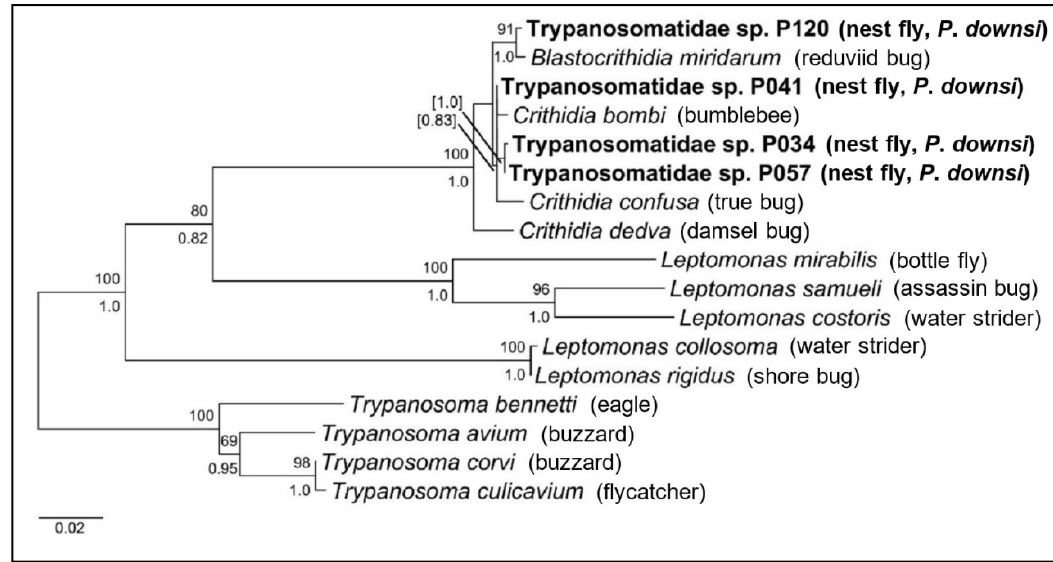
Figure 2. A Maximum Likelihood (ML) phylogenetic tree estimate of trypanosomatid parasite sequences derived from the 18S rRNA gene. The final alignment, deposited in [54], includes 1033 b.p, of which 271 sites were parsimony informative. Sequences from our infected Philornis downsi samples are indicated in bold. The tree was rooted with species from the Trypanosoma genus that infect avian hosts. Support values above 80% are displayed, with bootstrap values listed above nodes and Bayesian inferred posterior probabilities listed below nodes. The number of site substitutions are indicated by tree branch lengths. Accession numbers for all sequences used are listed in Table S3.